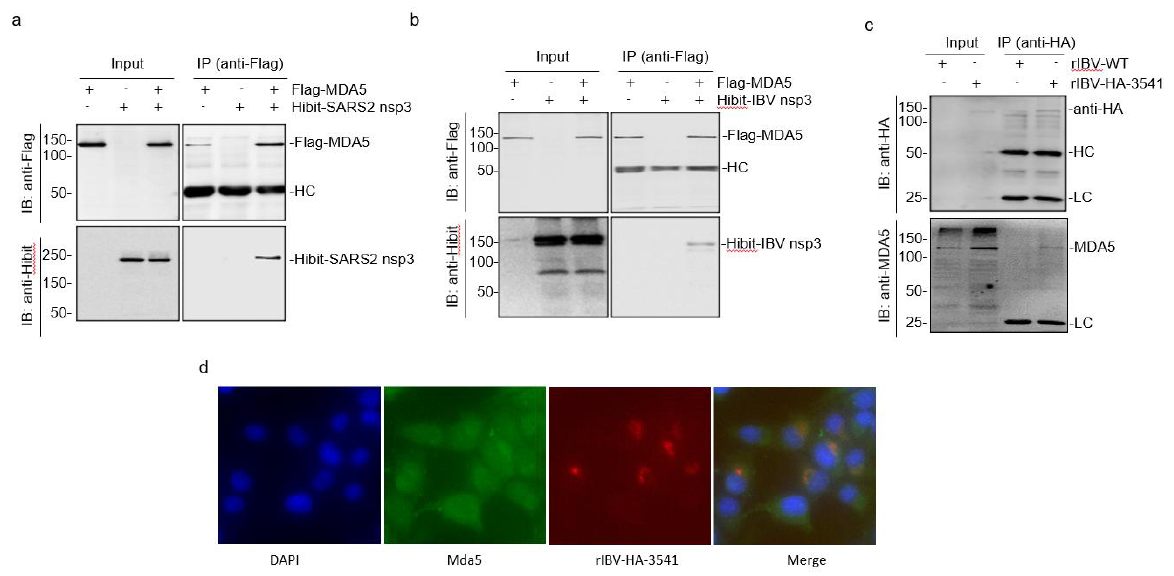
Figure 2. Interaction of MDA5 with SARS-CoV-2 and IBV nsp3. ( a ) Co-immunoprecipitation of SARS-CoV-2 nsp3 with MDA5. HEK293T cells were transfected with Flag-MDA5 and Hibit-tagged SARS-CoV-2 nsp3 (Hibit-SARS2-nsp3), harvested at 24 h post-infection, total cell lysates prepared and subjected to immunoprecipitation with anti-Flag beads. Total cell lysates (Input) and precipitates [IP (anti-Flag)] were analyzed by Western blot with anti-Flag and anti-Hibit antibodies, respectively. Numbers on the left indicate protein sizes in kilodalton. ( b ) Co-immunoprecipitation of IBV nsp3 with MDA5. HEK293T cells were transfected with Flag-MDA5 and Hibit-tagged IBV nsp3 (Hibit-IBV-nsp3), harvested at 24 h post-infection, total cell lysates prepared, and subjected to immunoprecipitation with anti-Flag beads. Total cell lysates and precipitates were analyzed by Western blot with anti-Flag and anti-Hibit antibodies, respectively. Numbers on the left indicate protein sizes in kilodalton. ( c ) Co-immunoprecipitation of IBV nsp3 with MDA5 in IBV-infected cells. Confluent H1299 cells were infected with wild-type (rIBV-WT) and rIBV-HA-3541-nsp3 at an MOI~2, respectively. Cells were harvested at 20 h post-infection, total cell lysates prepared and subjected to immunoprecipi- tation with anti-HA beads. Total cell lysates and precipitates were analyzed by Western blot with anti-HA and anti-MDA5 antibodies, respectively. Numbers on the left indicate protein sizes in kilodalton. ( d ) Colocalization of the endogenous MDA5 with the HA-tagged IBV nsp3 in H1299 cells infected with rIBV-HA-3541-nsp3. Cells were infected with rIBV-HA-3541-nsp3 at an MOI~2, fixed at 24 h post-infection, permeabilized, and double-labeled with mouse anti-HA and rabbits anti-MDA5 antibodies. MDA5 was immunostained with Alexa Fluor 488-linked anti-rabbit IgG, the HA-nsp3 was stained with Alexa Fluor 594-linked anti-mouse IgG, and cellular nuclei were stained with DAPI (Hoechst